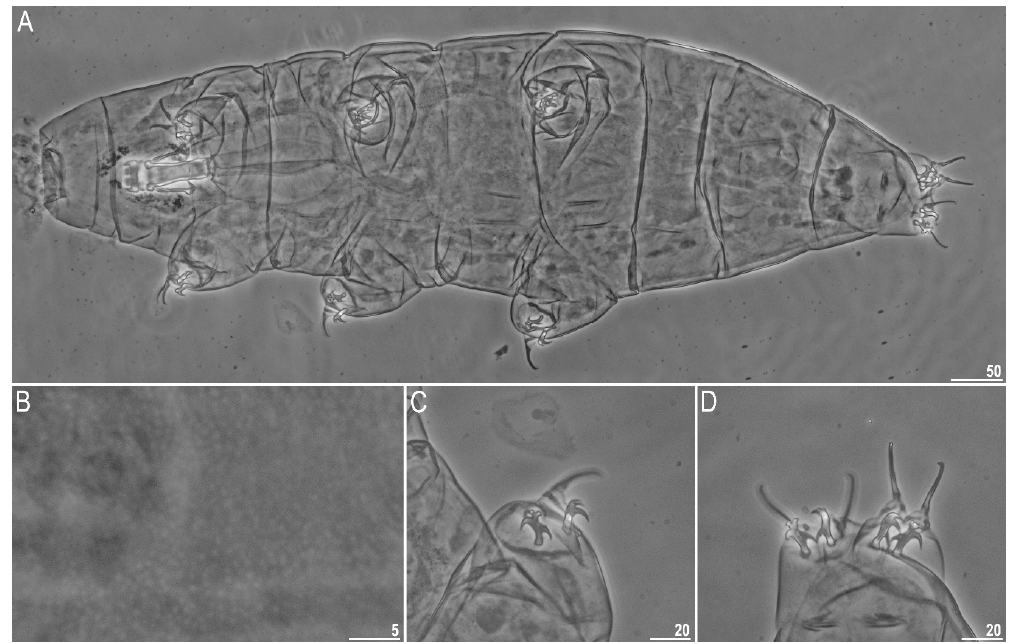
Figure 1. Milnesium quadrifidum . ( A ) Dorso-ventral projection of the entire animal; ( B ) Pseudopores visible on the dorsal side of the body; ( C ) Claws II; ( D ) Claws IV. Scale bars in ( µ m). All PCM (Phase Contrast Microscopy).